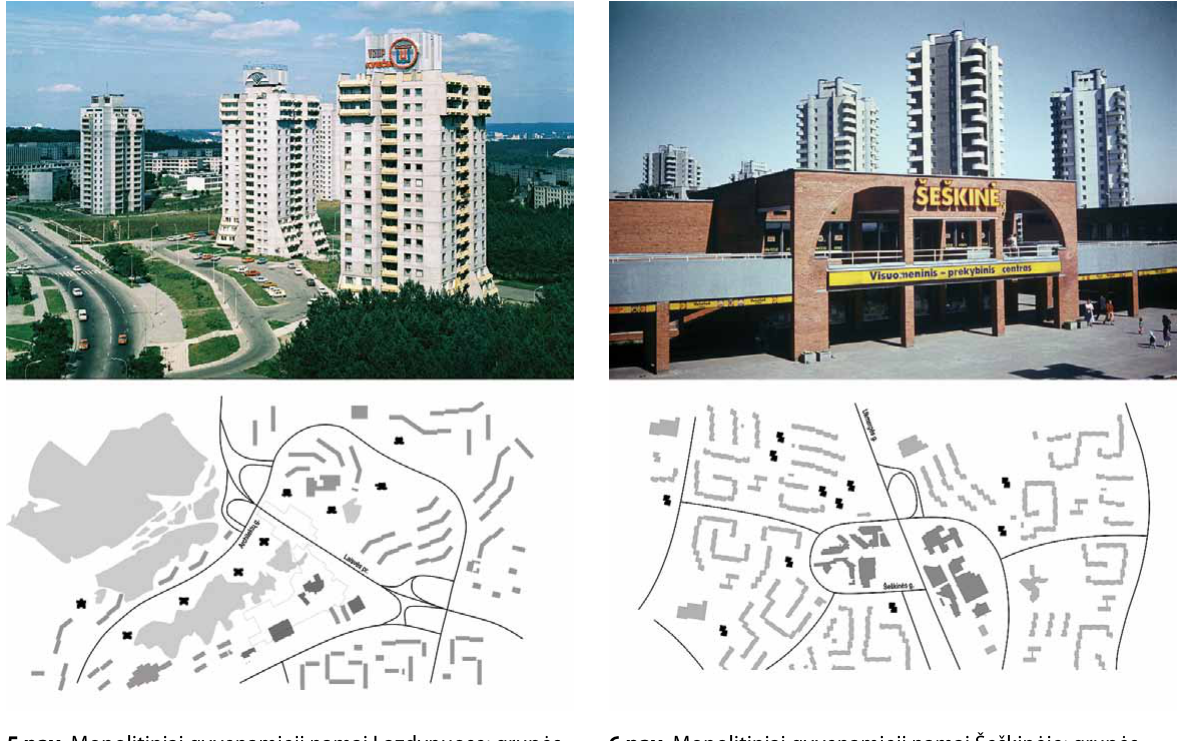
Fig. 5. Tower blocks in lazdynai: view of the group, layout of the district